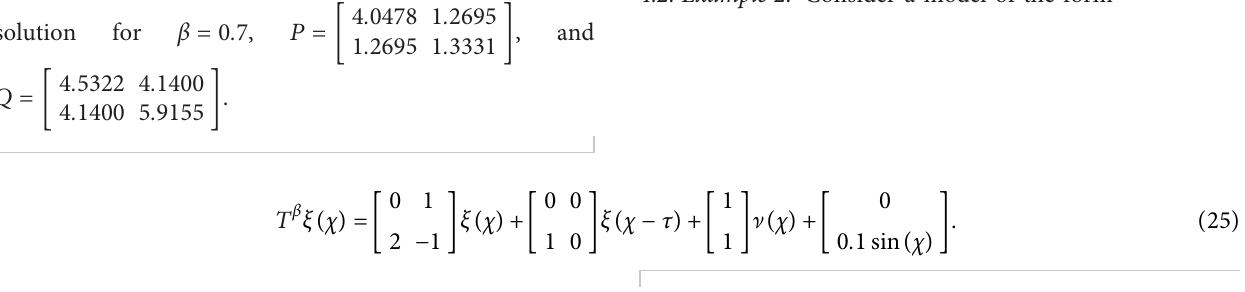
for σ � 0 . 1, σ � 0 . 5, and σ � 1 . 99. 1